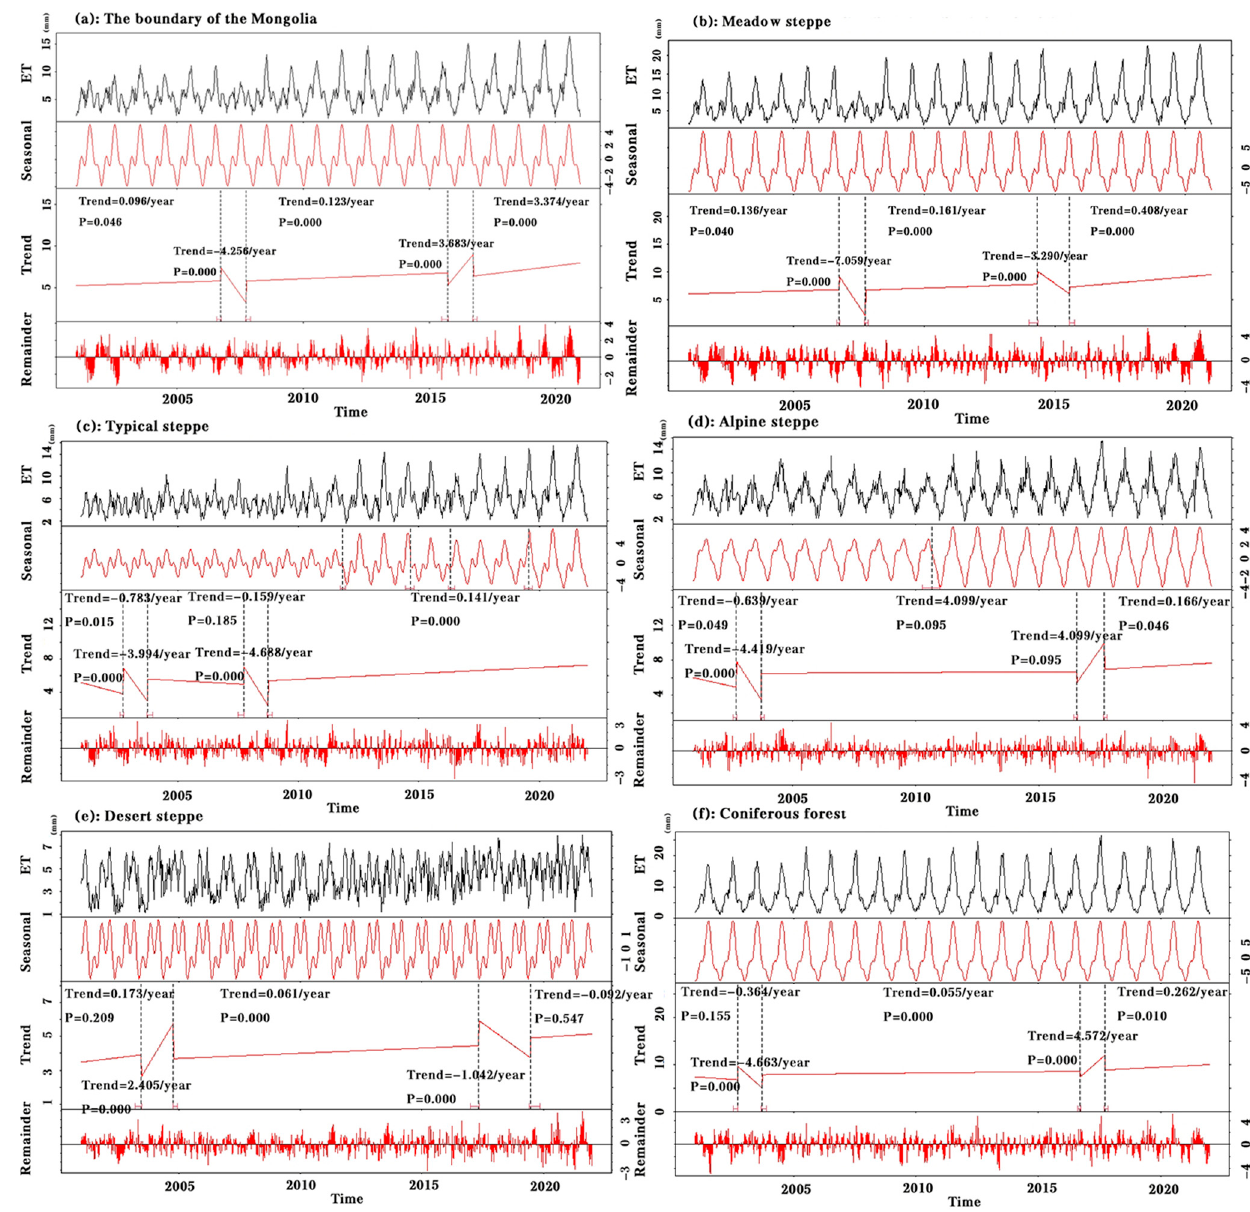
Figure 10. Abrupt breakpoints in BFAST-detected shifts in the 8-day ET for 2001–2020 at the bound- ary of Mongolia and for the different vegetation types in Mongolia: ( a ) boundary of Mongolia, ( b ) meadow steppe, ( c ) typical steppe, ( d ) alpine steppe, ( e ) desert steppe, and ( f ) coniferous forest.